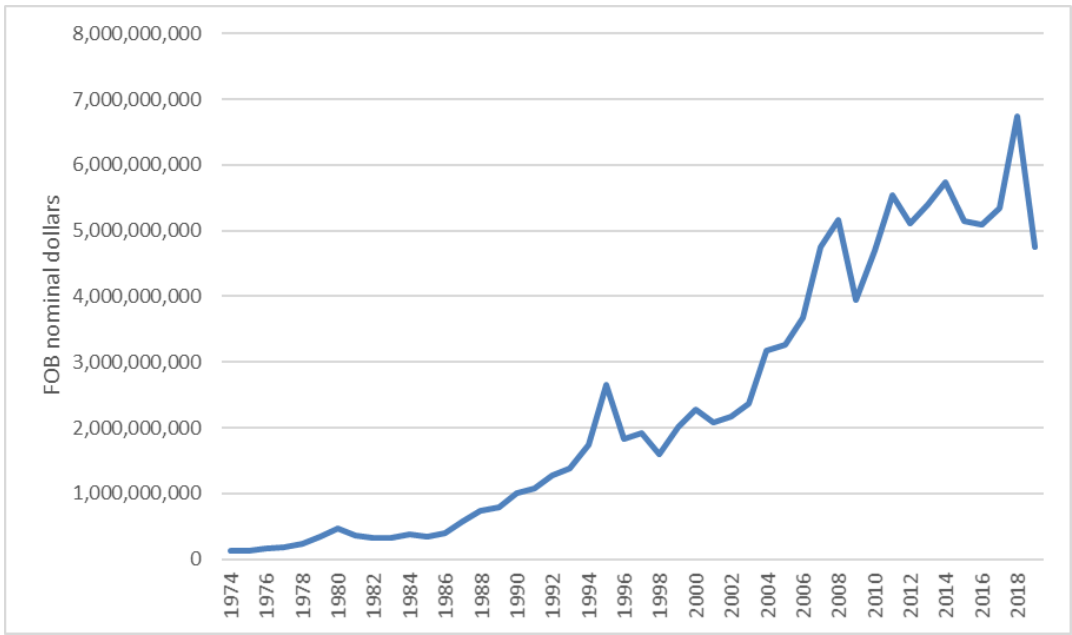
Figure 5. Evolution of forest exports in free on board (FOB) nominal dollars.